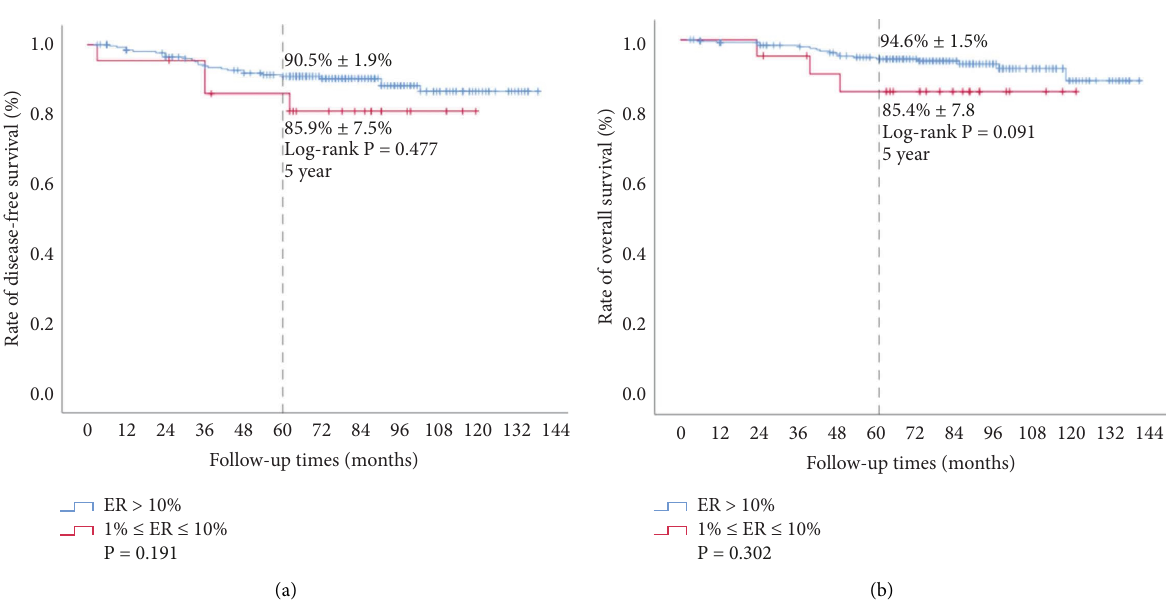
Figure 2: Survival analysis of the high ER (ER > 10%, H group) and low ER (1% < ER < 10%, L group) group. Kaplan–Meier survival curves were plotted, and the log-rank test was performed to compare the overall survival and disease-free survival between the H group and the L